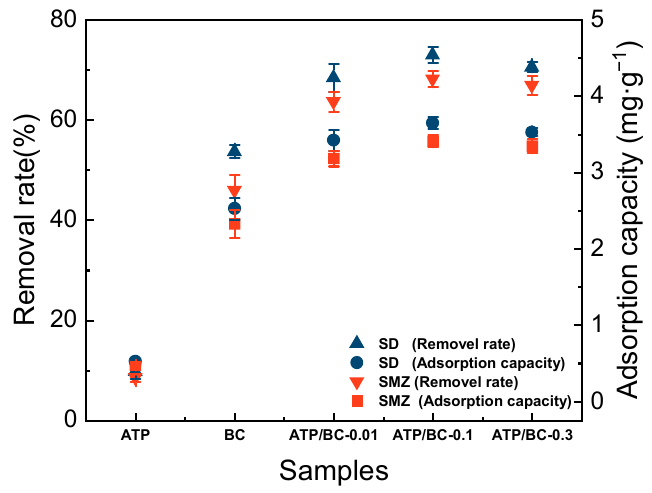
Figure 4. Effect of the mass ratio of ATP to rice straw on the adsorption SD and SMZ.